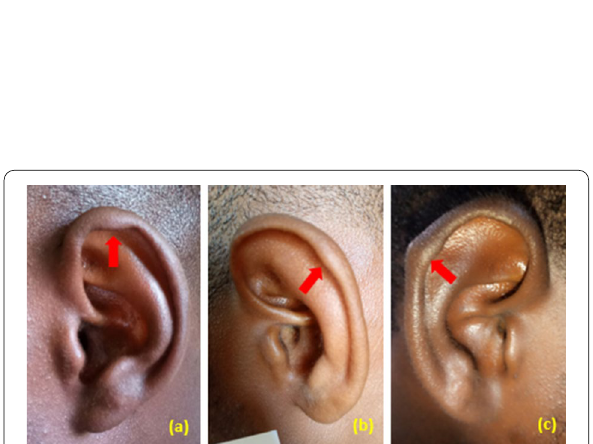
Fig. 8 Photographs of forms of Darwin’s tubercle: enlarged ( a ), projected ( b ), nodosity ( c